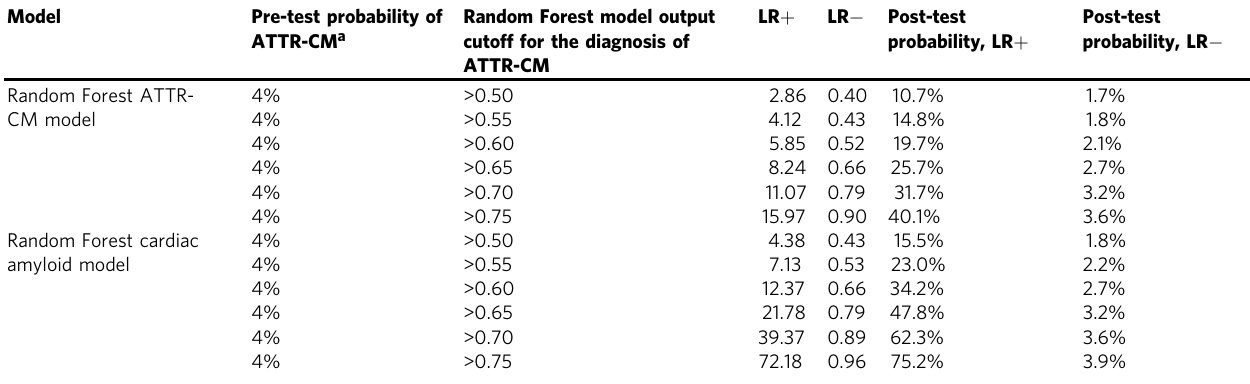
Table 5 Post-test probabilities for the Random Forest ATTR-CM and cardiac amyloid Random Forest models based on model performance in the Northwestern Medicine Enterprise Data Warehouse Heart Failure